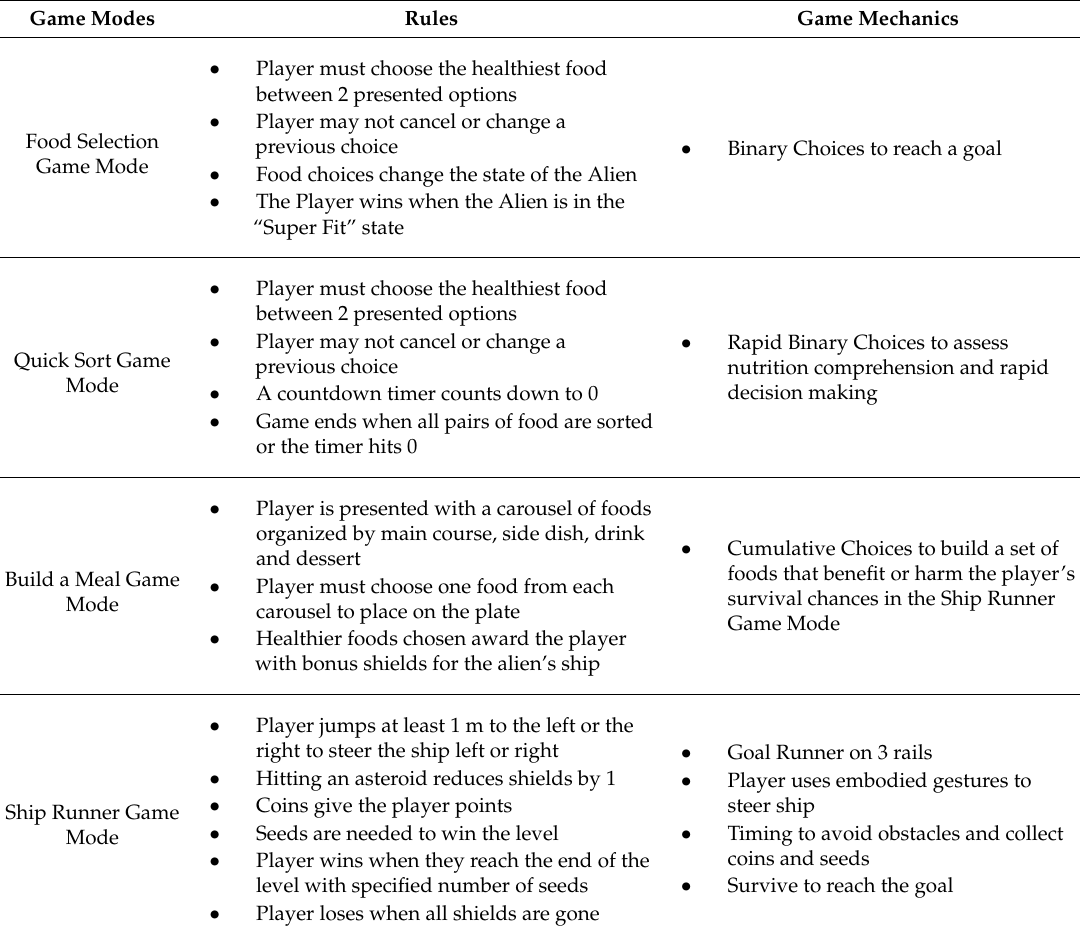
Table 1. Gamemodes, rules, andgamemechanicsofthe“AlienHealth”aspresentedbyHermansetal.[69]. Game Modes Rules Game Mechanics